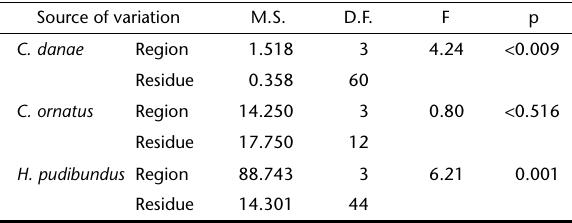
Table II. Analysis of Variance (ANOVA) comparing infestation intensity between branchial chamber regions. (M.S.) Mean square, (D.F.) degrees of